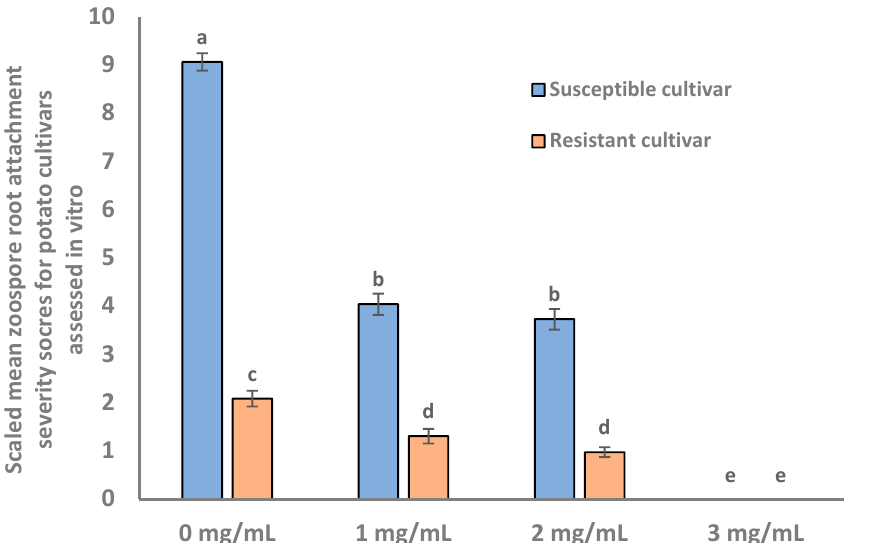
Figure 6. The concentration ranges of pectinase treated potato root segments to zoospore root attachment. The vertical bars represent standard error (n = 3). p (cultivars) < 0.001, p (concentration) < 0.001, p (cultivar × concentration) < 0.001. LSD (0.05) = 0.43. Bars that are labelled with different letters indicate values that are significantly different from each other.